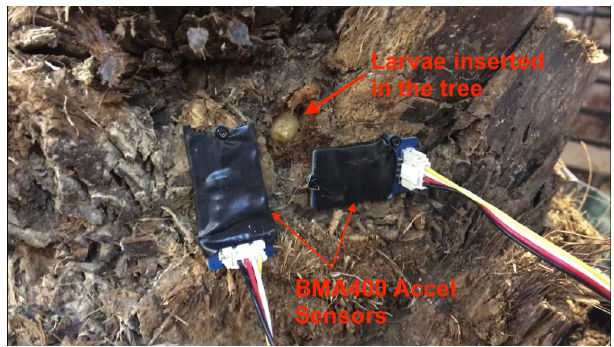
Figure 7. Position of the sensors to detect Red Palm Weevil (Outside Sensors).